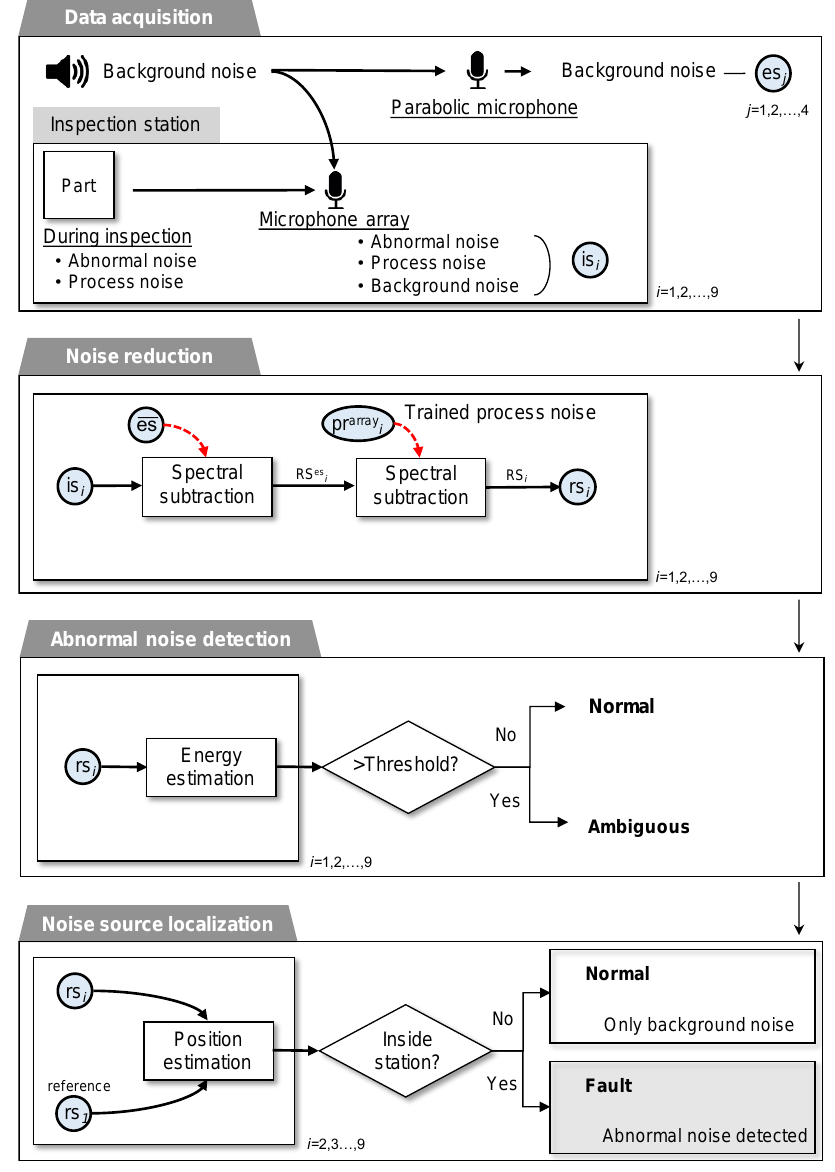
Figure 5. Overview of the four phases of the in-process BSR detection procedure: Data acquisition, Noise reduction, abnormal noise detection, and Noise source localization.